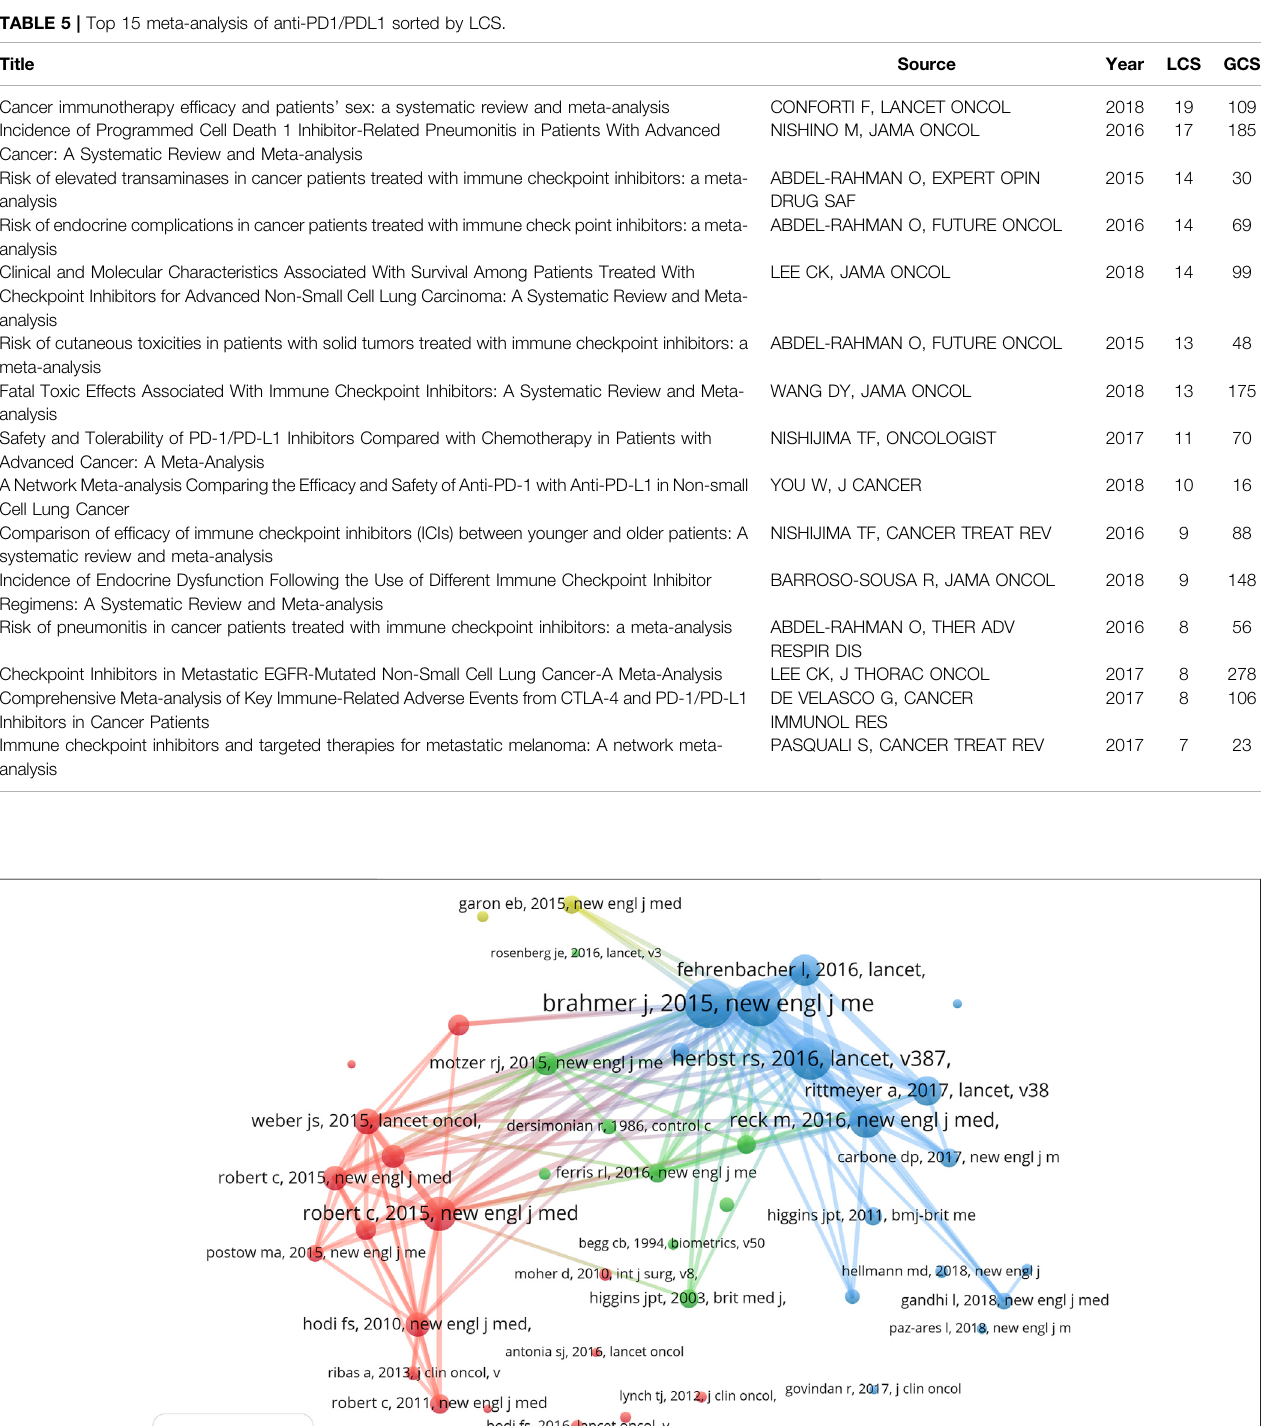
Frontiers in Pharmacology |